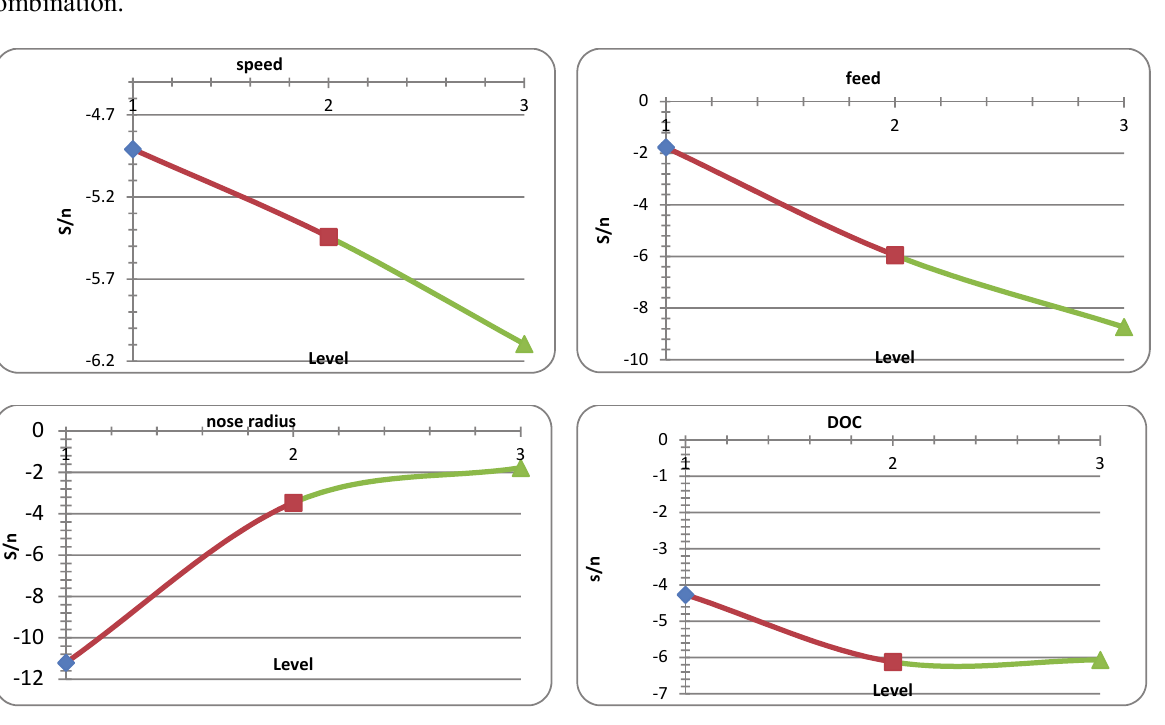
Fig. 2. S/N vs. Parameters; showing contribution of the parameters on R